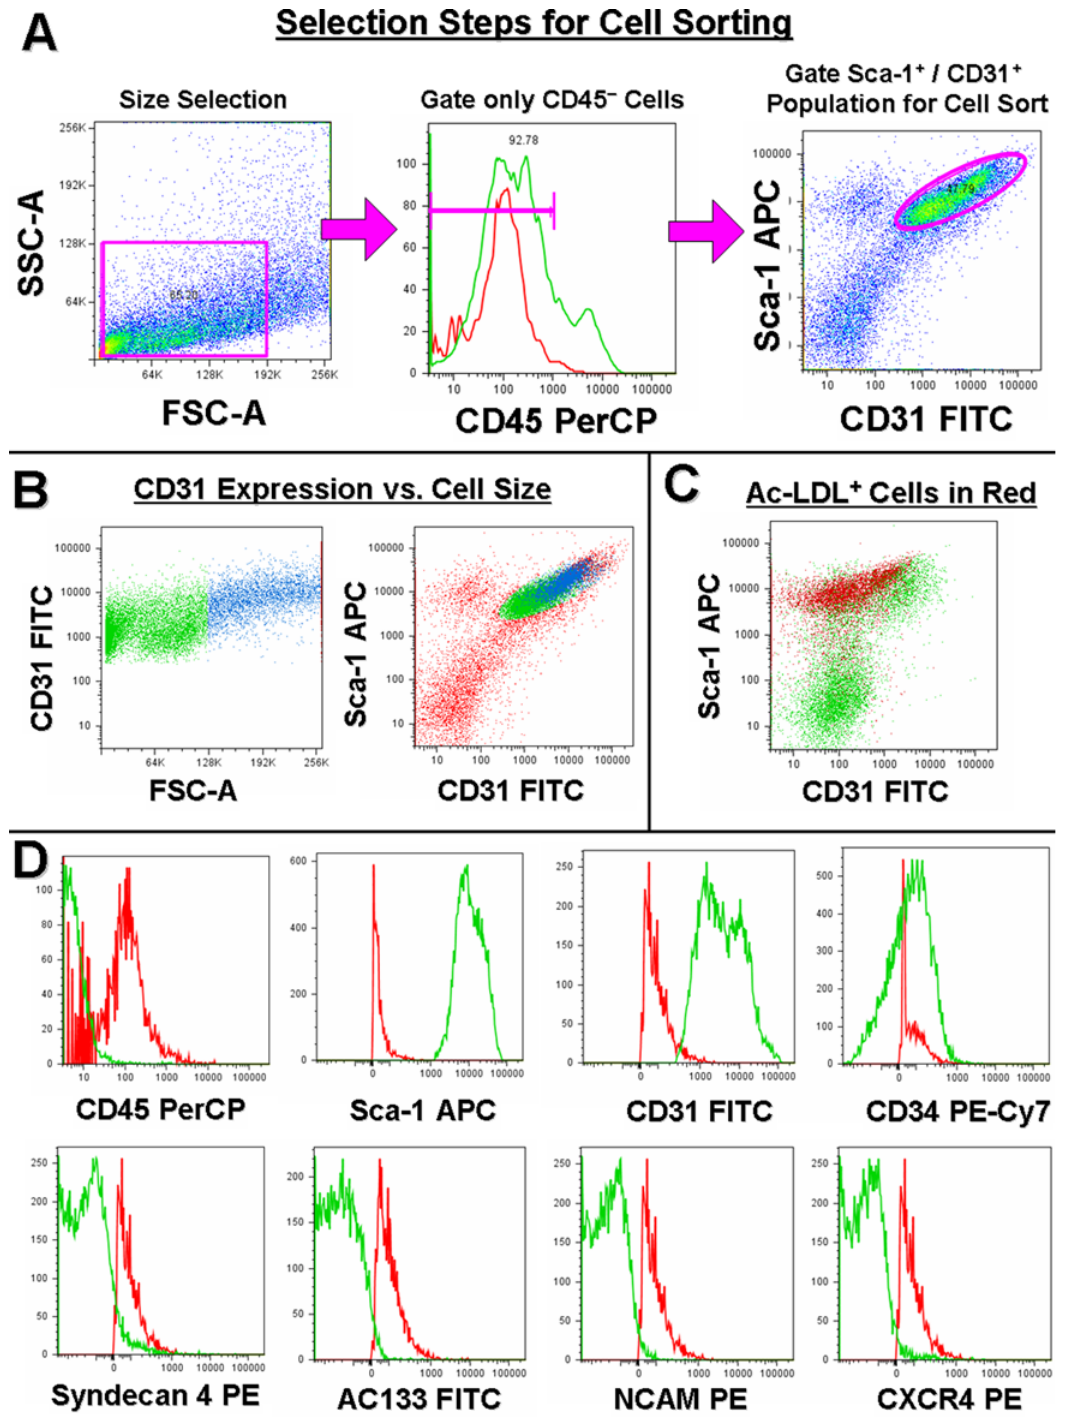
Figure 2. Flow-cytometry characterization of sorted EC. A, Stepwise selection for Sca-1 + , CD31 + , CD34 dim and CD45 2 endothelial cells (EC) begins by first gating (pink box, left dot plot) on small and low granulated cells within a SSC-A and FSC-A dot plot. CD45 + cells are then identified and gated out by comparing the sample (green peak) with the unstained control (red peak) to reveal a Sca-1 + and CD31 + population of muscle EC within the CD45 2 population (pink bar, middle histogram). The Sca-1 + (vertical)/CD31 + (horizontal) endothelial population (pink oval, right dot plot) which is dim for CD34 can then be gated for further analysis or cell sorting. B, Endothelial CD31 FITC expression correlates with cell size as FSC-A comparison indicates larger cells (blue) express more CD31. C, 45% of EC are positive for ac-LDL rhodamine uptake (red) within the entire CD45 2 population (green) portrayed in Sca-1 APC (vertical) and CD31 FITC (horizontal). D, The endothelial cells defined as Sca-1 + , CD31 + and CD34 dim are homogeneously negative for CD45 PerCP, positive for Sca-1 APC and CD31 FITC, and dim for CD34 PE Cy7 (green peaks) vs. unstained controls (red peaks). Analysis of separate aliquots from the same muscle preparations revealed EC lack Syndecan 4 PE, AC133 FITC, NCAM PE and CXCR4 PE (green peaks EC samples, red peaks unstained control).